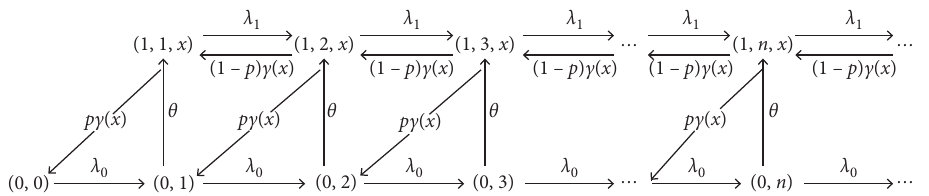
Figure 1: Transition rate diagram in the mail service